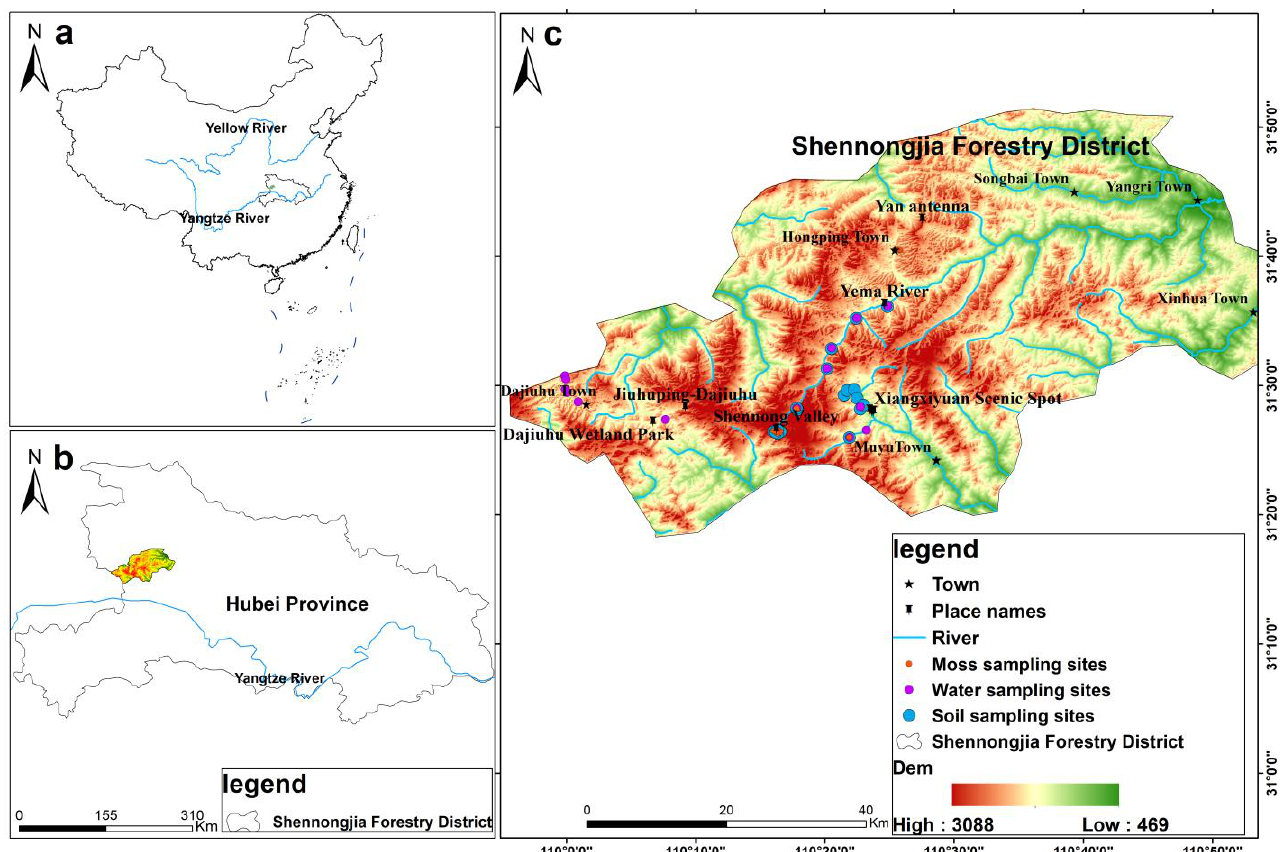
Figure 1. Map of the study area and sampling sites. ( a ) Hubei Province, China; ( b ) Shennongjia alpine critical zone in Hubei Province (the study area); ( c ) distribution of sampling sites across SNJ.